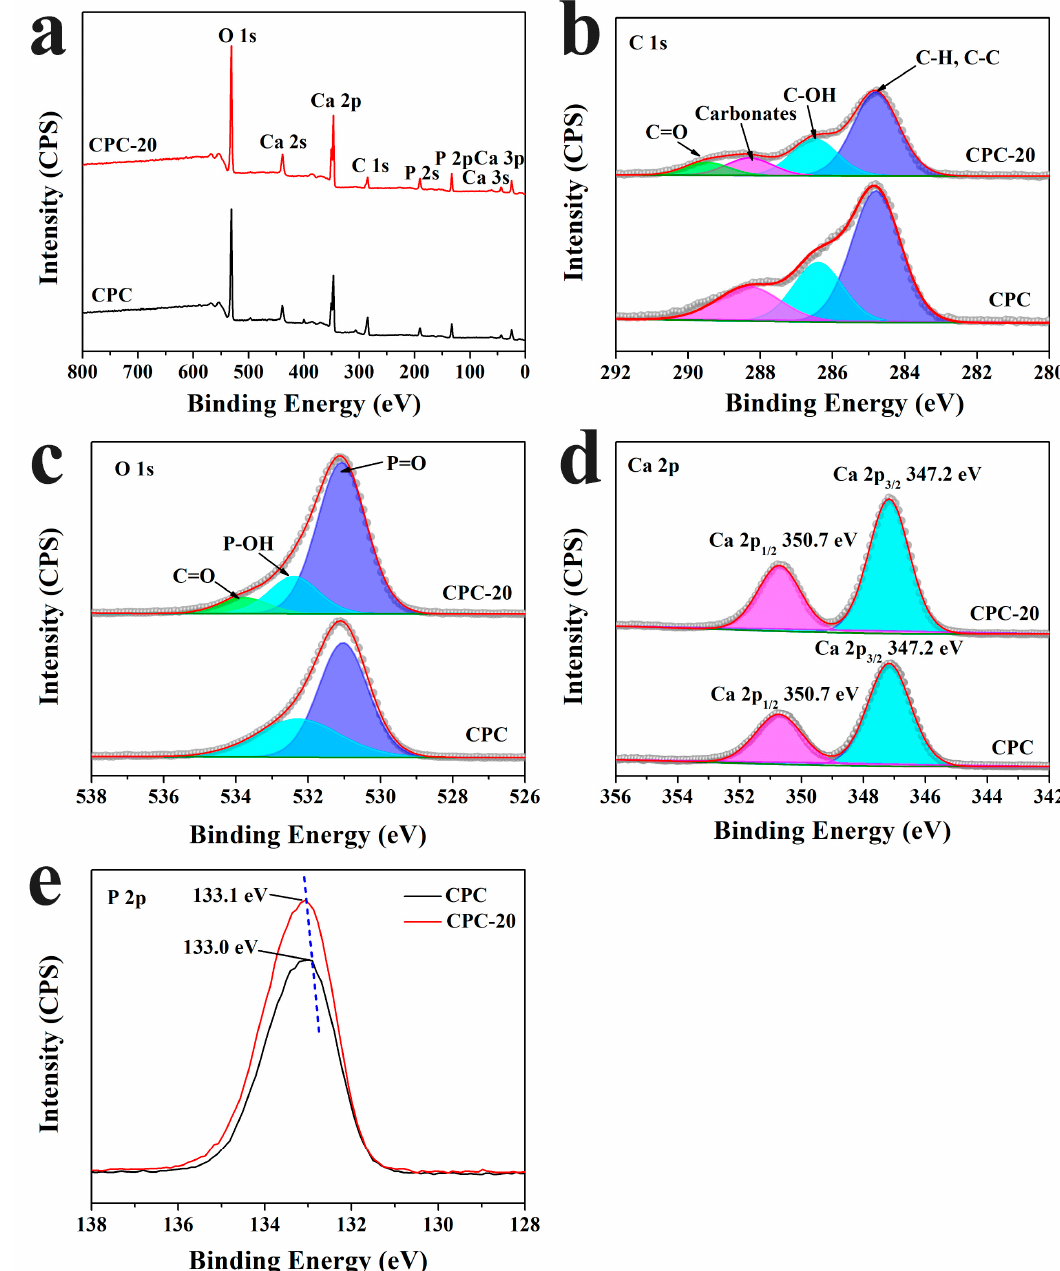
Figure 12. XPS spectra of the surface of CPC and CPC-20 after soaking for three days. ( a ) Wide scan XPS spectra; ( b ) C 1s; ( c ) O 1s; ( d ) Ca 2p; ( e ) P 2p.